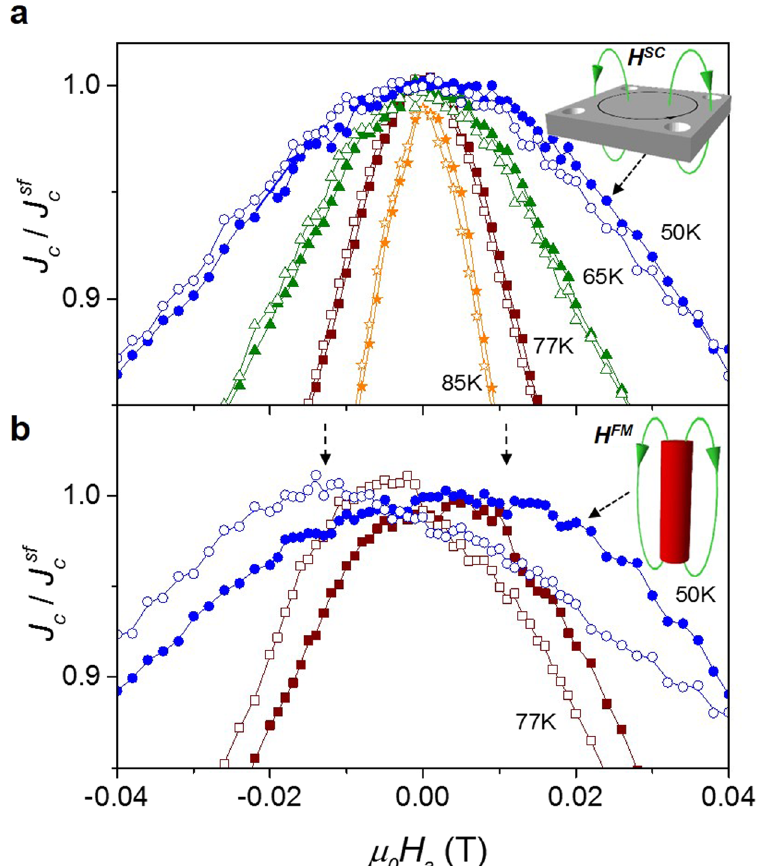
Figure 2. Hysteretic behaviour of J c . Normalized critical current density vs. applied magnetic field at different temperatures for a bridge with ( a ) antidots and ( b ) antidots filled with nano-rods, measured by decreasing field (closed symbols) and increasing field (open symbols). Dashed vertical arrows indicate the value of H peak for the J c (H a ) curves measured at 50 K. Upper and lower insets show a schematic representation of trapped stray fields generated by SC loops, H SC , and Co nano-rods, H FM , respectively, in the first quadrant of closed